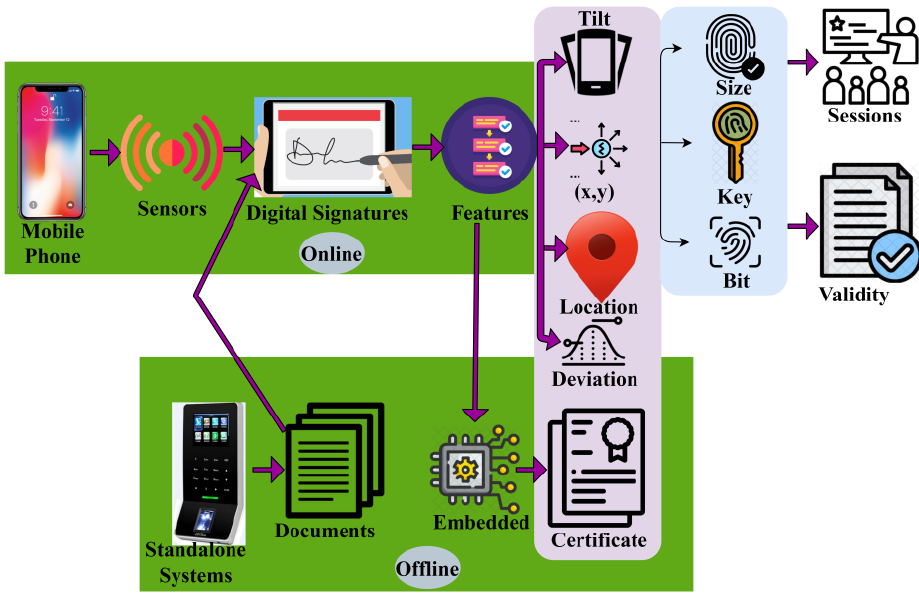
Figure 5. Distinguishing signatures.